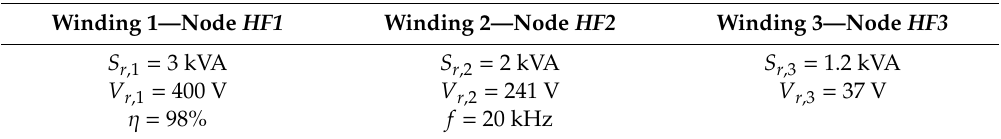
Table 1. HF transformer technical specifications.